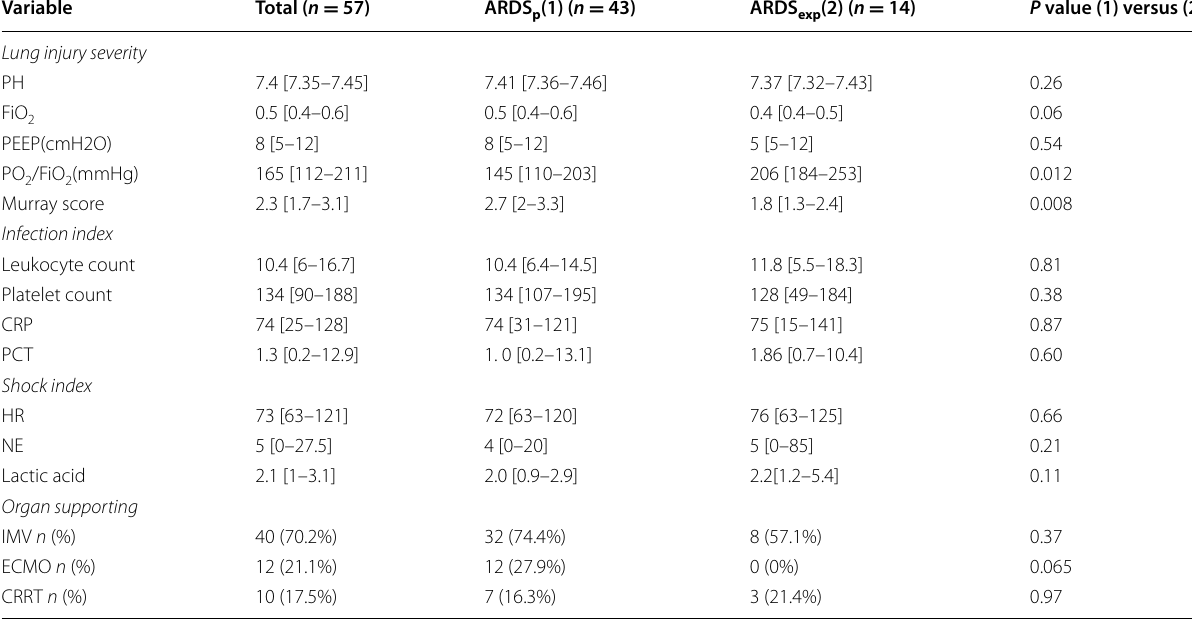
Table 3 Comparison of patient’s clinical condition indexes between ARDSp and ARDSexp